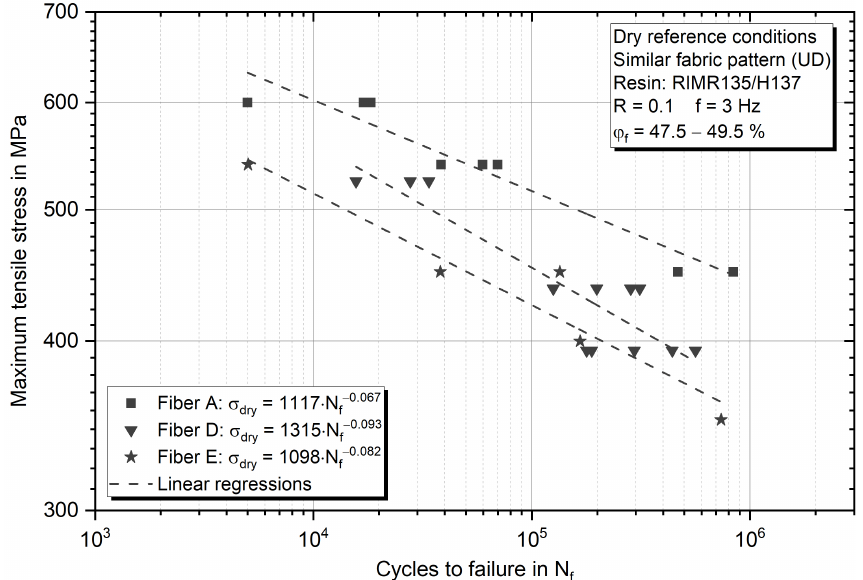
Figure 10. Fatigue life diagram of dry reference UD GFRP materials (0 ◦ ) with initially different interphase strengths (Fiber A > Fiber D > Fiber E) and similar NCF structures.